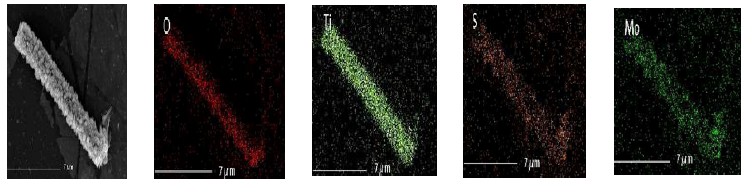
Figure 5. EDS mapping results from PI/TiO 2 @MoS 2 .